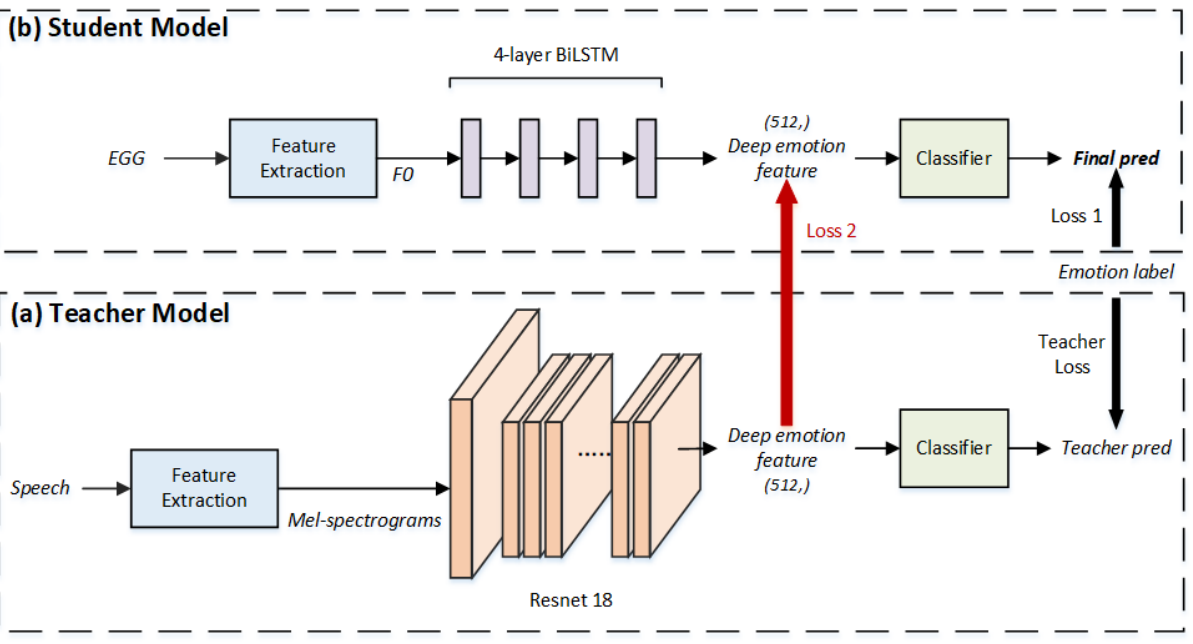
Figure 2. Illustration of the proposed framework, which consists of two phases: ( a ) training a strong teacher model based on the acoustic features from speech signals and ( b ) training the student model via cross-modal emotion distillation (CMED) with the pre-trained teacher